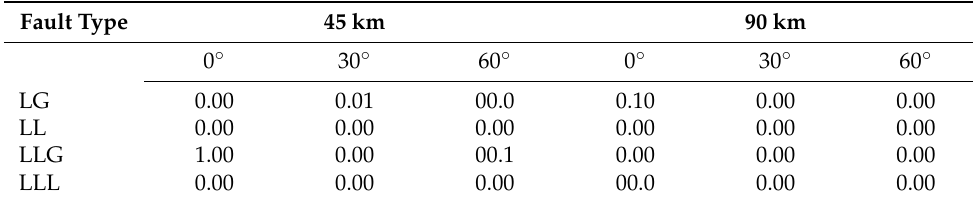
Table 12. AE at 45 and 90 km with a 10 Ω fault impedance.